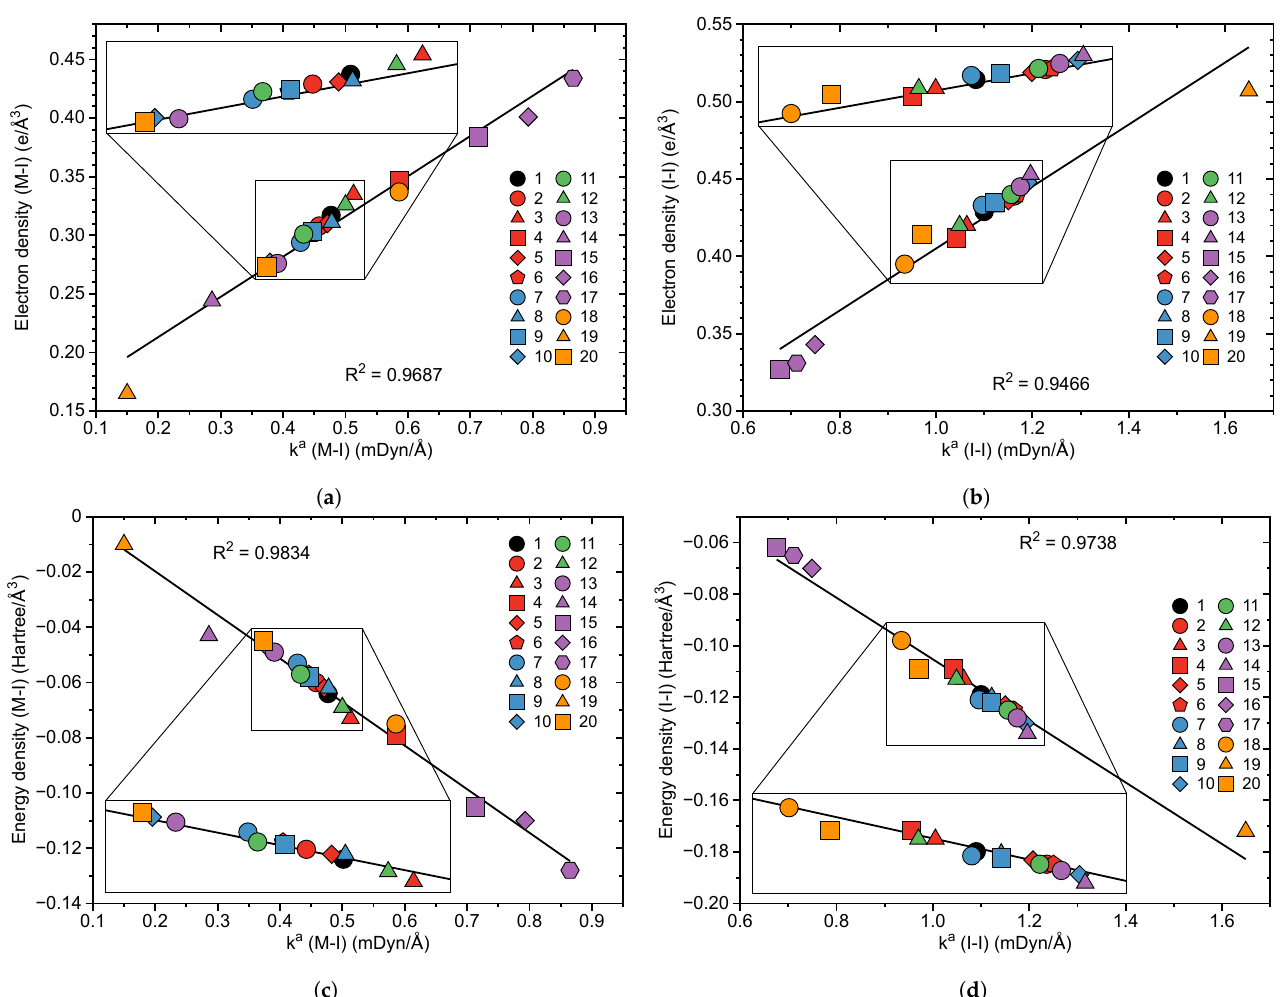
Figure 5. ( a ) Correlation between the electron density ρ b at the bond critical point r b and k a for the M − I bonds; ( b ) Correlation between the electron density ρ b and k a for the I − I bonds; ( c ) Correlation between the energy density H b at the bond critical point r b and k a for the M − I bonds; ( d ) Correlation between the energy density H b and k a for the I − I bonds of